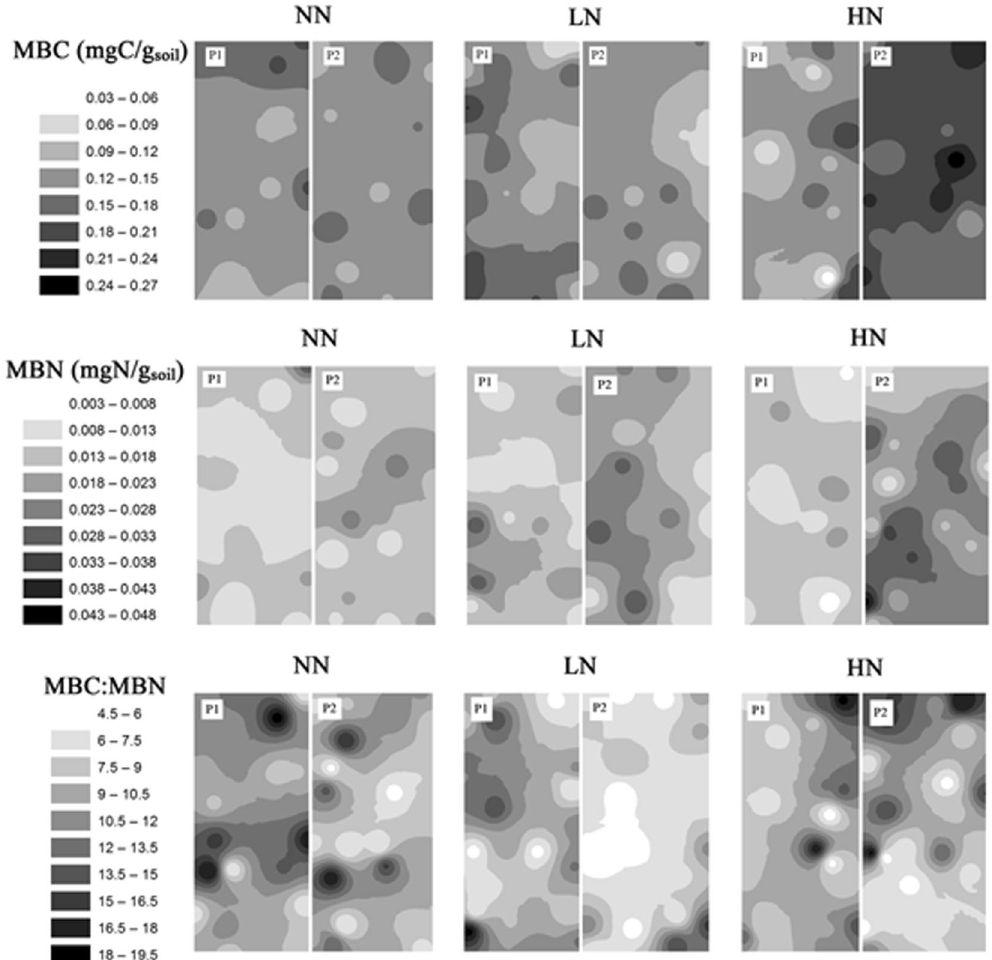
Figure 8. Spatial distribution of soil MBC and MBN concentrations and MBC:MBN under three N fertilization treatments (i.e. NN, LN and HN) in SG cropland soil in a three-year long fertilization experimental site at the Tennessee State University (TSU) Agricultural Research Center in Nashville, TN, USA. The interpolation maps were produced by inverse distance weighting (IDW) method. The abbreviations are referred to Table